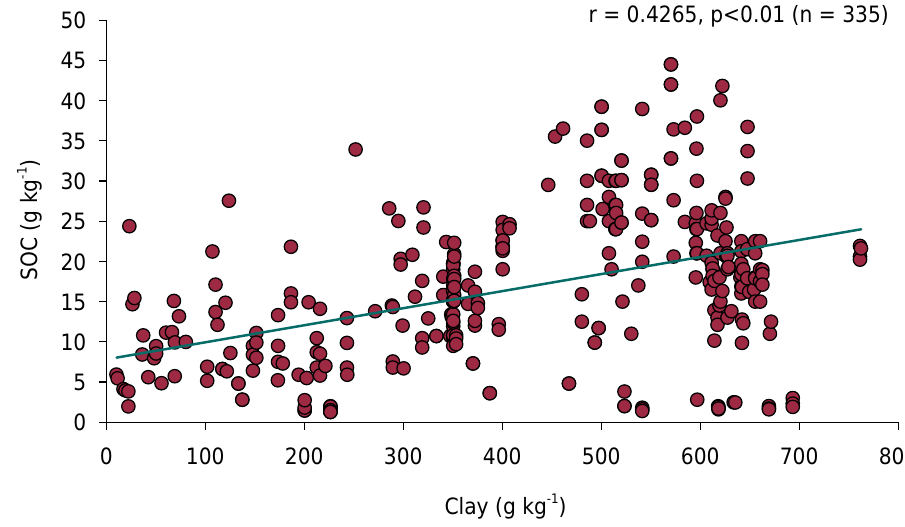
Figure 5. Correlation between clay content (g kg -1 ) and organic C (g kg -1 ) in soils from Brazilian Cerrado. r: Pearson’s correlation coefficient, statistically significant at 1% level. n: number of